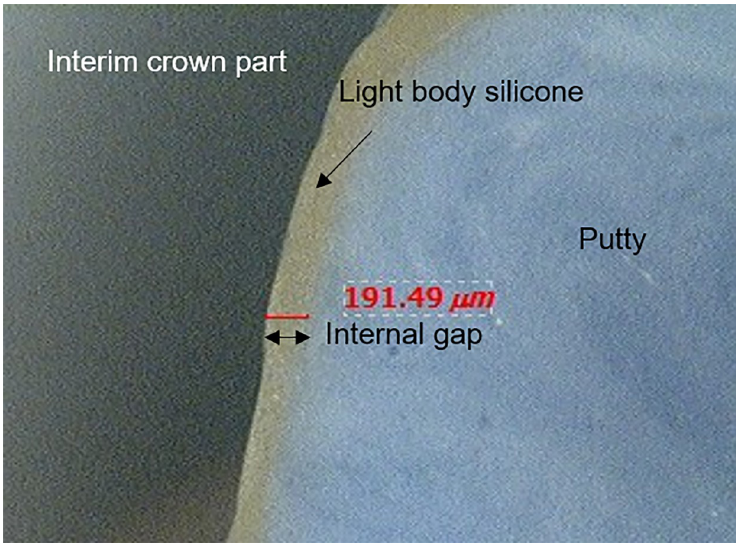
Fig 12. Measurement of marginal and internal gaps using a digital microscope (magnification ×